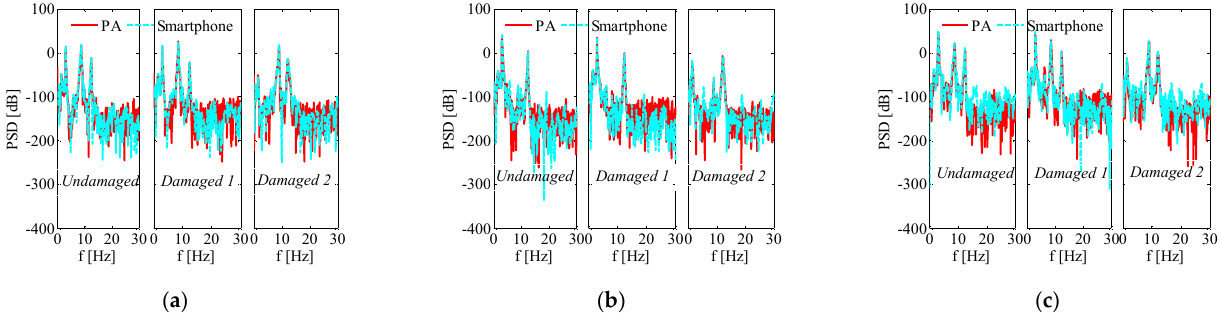
Figure 5. Using acceleration time history measurements from Figure 4, the power spectral density functions for the ( a ) first, ( b ) second, and ( c ) third floors were computed and plotted.